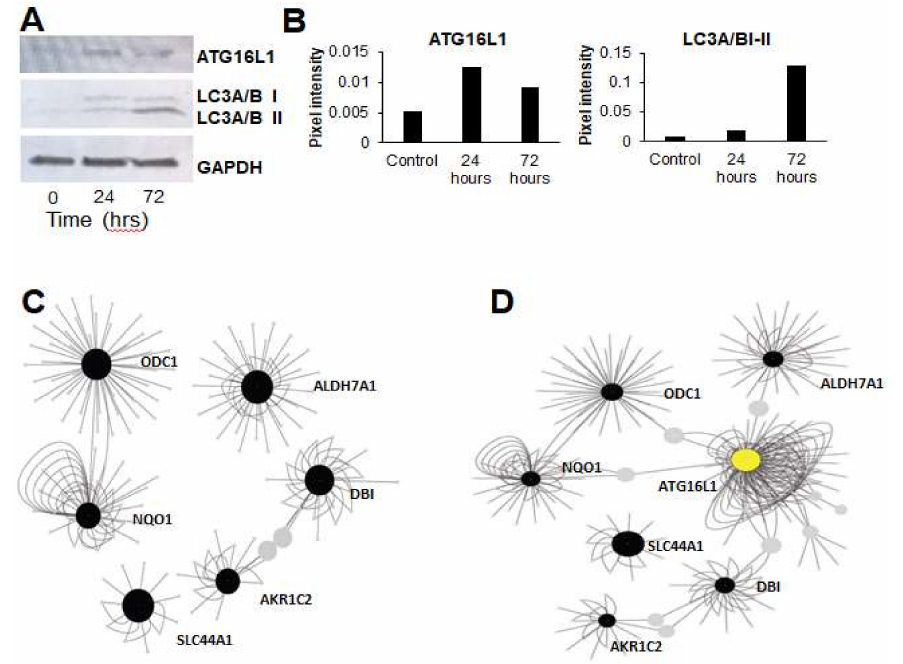
Figure 5. Epithelial-mesenchymal transition induces activation of autophagy and links to an amine production gene network. ( A ) TGF- β -induced epithelial-mesenchymal transition led to up-regulation of autophagy markers ATG16L1 and MAP1LC3A (LC3A/B). ( B ) Densitometric quantification of the western blotting data in A. ( C ) Cytoscape networks of amine production genes identified in Figure 4 showed few interactions between sub-networks. ( D ) Addition of the autophagy regulator, ATG16L1 (yellow circle), acted as a central hub to connect all amine metabolism